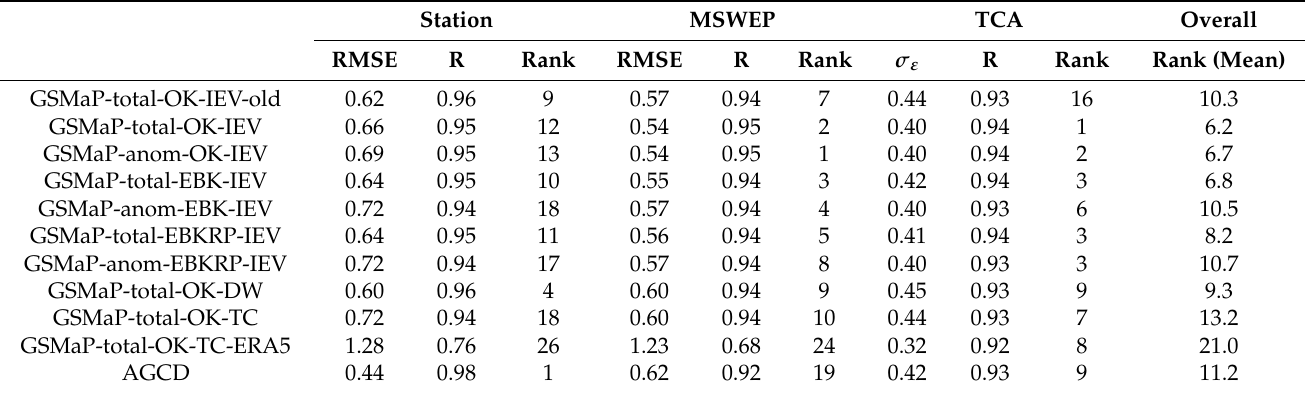
Table 3. Verification statistics for blended datasets with AGCD included as a reference.